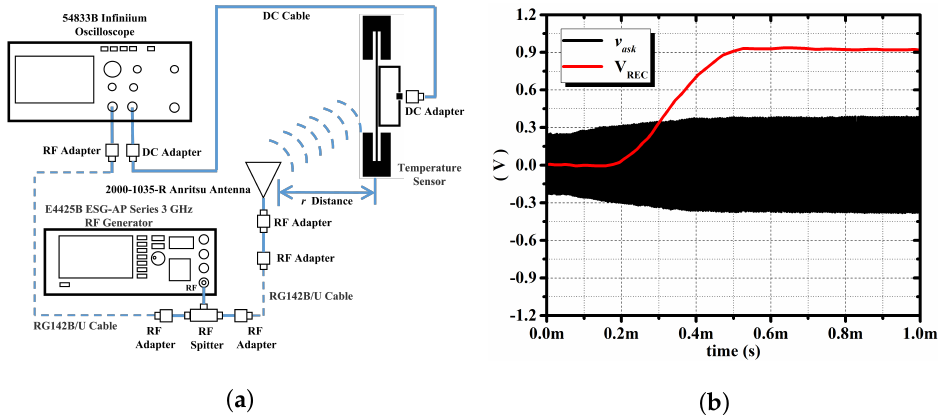
Figure 30. RF power harvester characterization. ( a ) Testbench. ( b ) Transient measurement response.